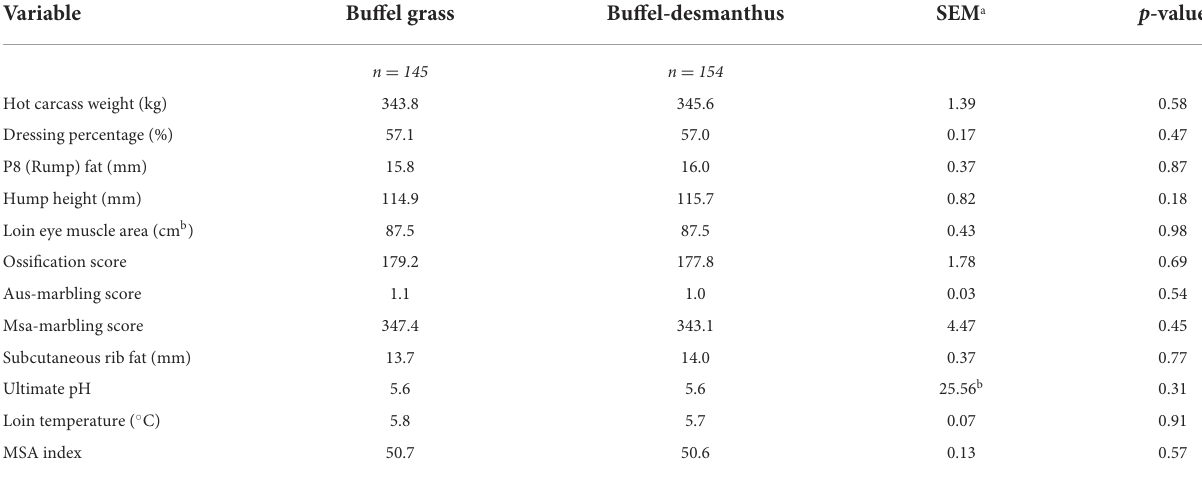
TABLE 4 Mean carcass characteristics of feedlot finished steers after backgrounding on buffel or buffel–desmanthu s